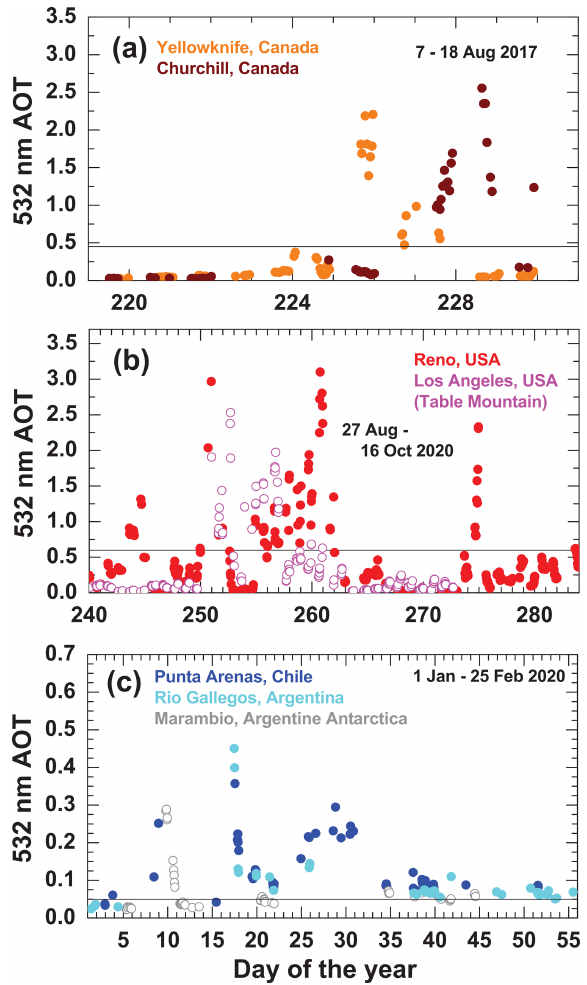
Figure 3. AERONET observations of strong smoke plumes in terms of 532nm AOT: (a) optically dense stratospheric smoke layers over northern-central Canada after the major pyroCb-related fire event in British Columbia, Canada, in the afternoon of 12 August 2017 (day 224), (b) tropospheric smoke over the western United States during major forest fires in the late summer and early autumn of 2020, and (c) aged stratospheric smoke over southern South Amer- ica and Antarctica in January and February 2020 about 10000km east of the Australian wildfires sources. The horizontal lines in- dicate the minimum AOT values considered in the determination of the conversion parameters. The smoke-free background 532nm AOT levels are (a) 0.025–0.05, (b) 0.1–0.25, and (c) 0.025–0.035.